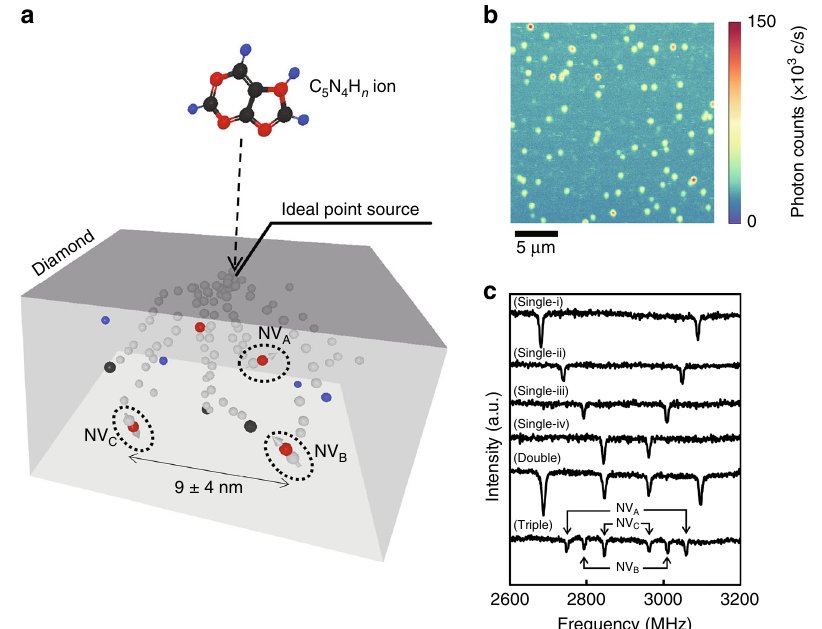
Fig. 1 CFM image and ODMR spectra of NV centres fabricated by C 5 N 4 H n ion implantation. a Fabrication of triple NV centre with nanometre separation by C 5 N 4 H n ion implantation. When a C 5 N 4 H n -65 keV ion hits the diamond, it decomposes into individual atoms. The red, black, and blue spheres represent nitrogen atoms, carbon atoms, hydrogen atoms, respectively. The vacancies are created by these ions and presented by grey spheres. During the annealing process, the vacancies mobilize and combined with substitutional nitrogen, interstitial carbon, and other vacancies. If the vacancy meets substitutional nitrogen, the NV centre is created and labelled by NV A , NV B , and NV C with dashed circles in the fi gure. The C 5 N 4 H n ion acts as an ideal point source, and the position of each atom is determined by ion straggling. The average distance and standard deviation of the implanted nitrogen atom were calculated to be 9 and 4 nm, respectively, by using the SRIM code. b Typical CFM image of C 5 N 4 H n ion implanted region. Yellow dots correspond to single NV centres, and bright red dots correspond to double and triple NV centres. c Typical ODMR spectra of single, double, and triple NV centres. Top four spectra (Single- i), (Single-ii), (Single-iii), and (Single-iv) show four single NV centres with different orientations. The spectra (Double) and (Triple) show double and triple NV centres, respectively. The spectra for triple NV centre are labelled NV A , NV B, and NV